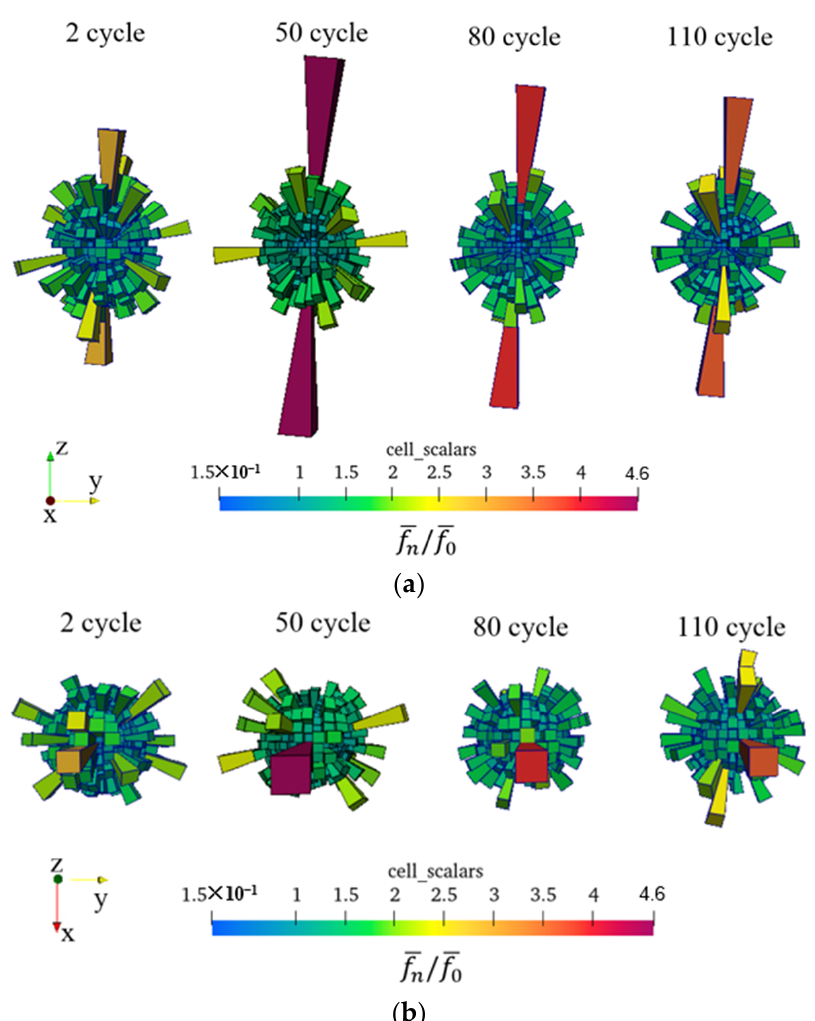
Figure 13. 3D spherical histogram of local average normal contact force f n under different gyratory compaction cycle: ( a ) in front view; ( b ) in vertical